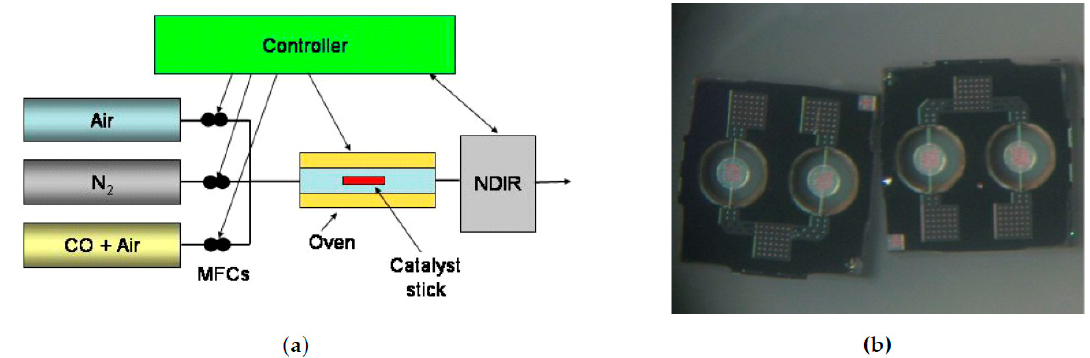
Figure 1. ( a ) The scheme of the experimental setup. The concentration of CO on the inlet and the outlet of the reactor were controlled by Rosemount NDIR instrument, the inlet concentration being measured using a bypass tube. The measurements of temperature downstream the catalytic samples showed that the catalytic combustion of CO does not increase gas temperature by more than 3 °C; ( b ) Optical view of the 1 × 1mm 2 pellistor chips for multisensory platform. The heaters in the centre of the membranes are is 120 µm diameter [2].